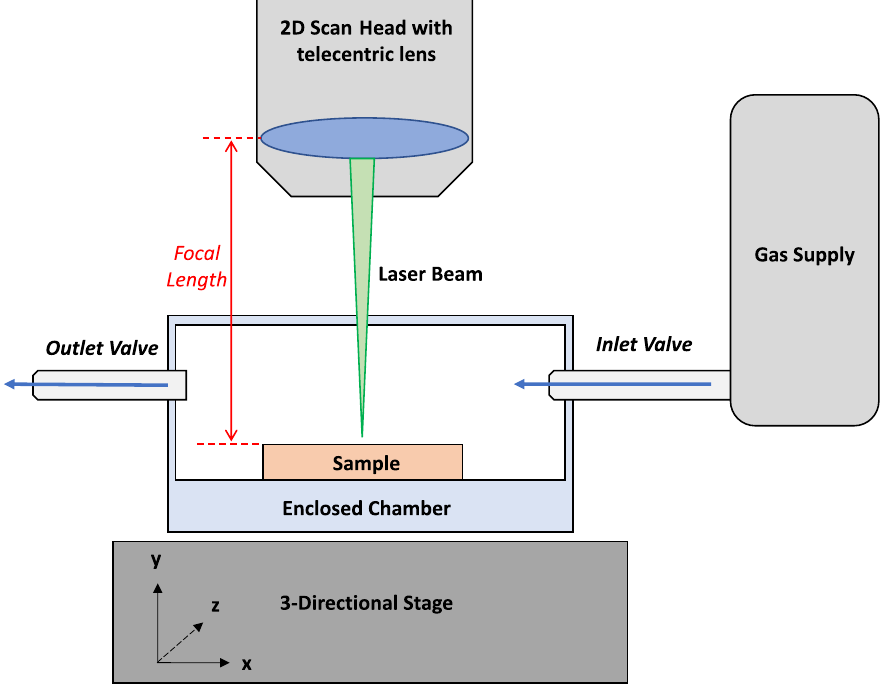
FIG. 1. Schematics of the laser treatment setup. The chamber was filled with gas of 99.998% purity at a flow rate of approximately 5 L = min. The system was then allowed to reach equilibrium for several minutes before processing